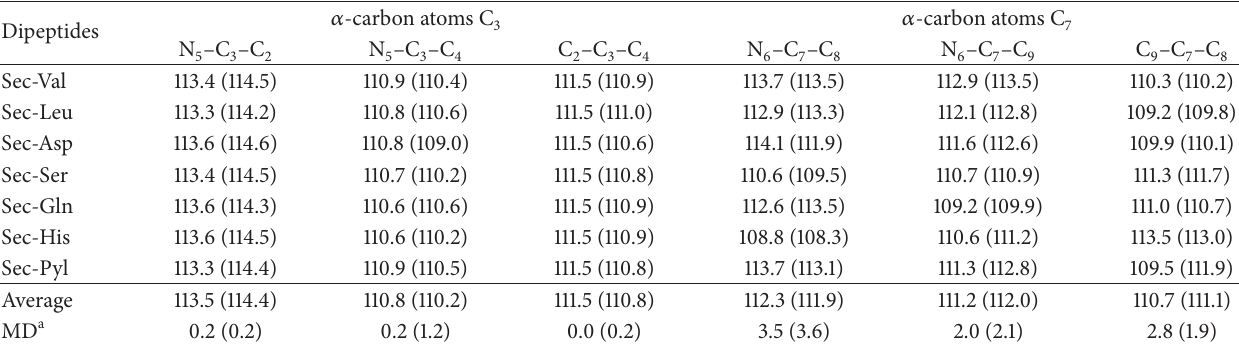
Table 5: Calculated bond angles (in degrees) for the 𝛼 -carbon atoms of the dipeptides; the gas phase values are given in brackets. Dipeptides